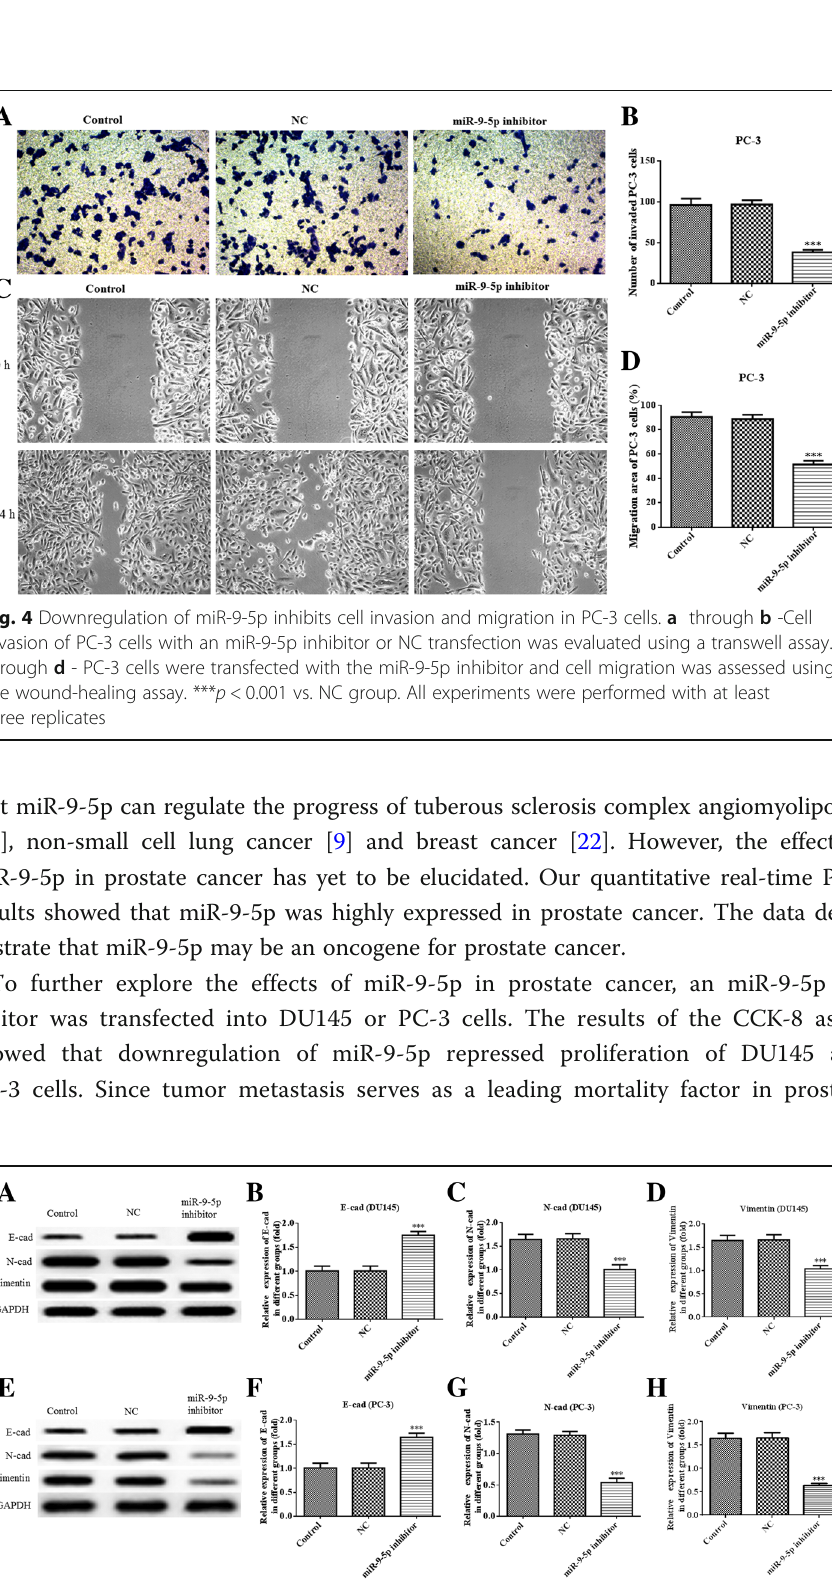
Fig. 5 Downregulation of miR-9-5p inhibits the expression of EMT-related proteins in DU145 and PC-3 cells. a through d – The protein expressions and quantifications of E-cadherin (E-cad), N-cadherin (N-cad) and vimentin and in DU145 cells. e through h – The protein expressions and quantifications of E-cad, N-cad and vimentin and in PC-3